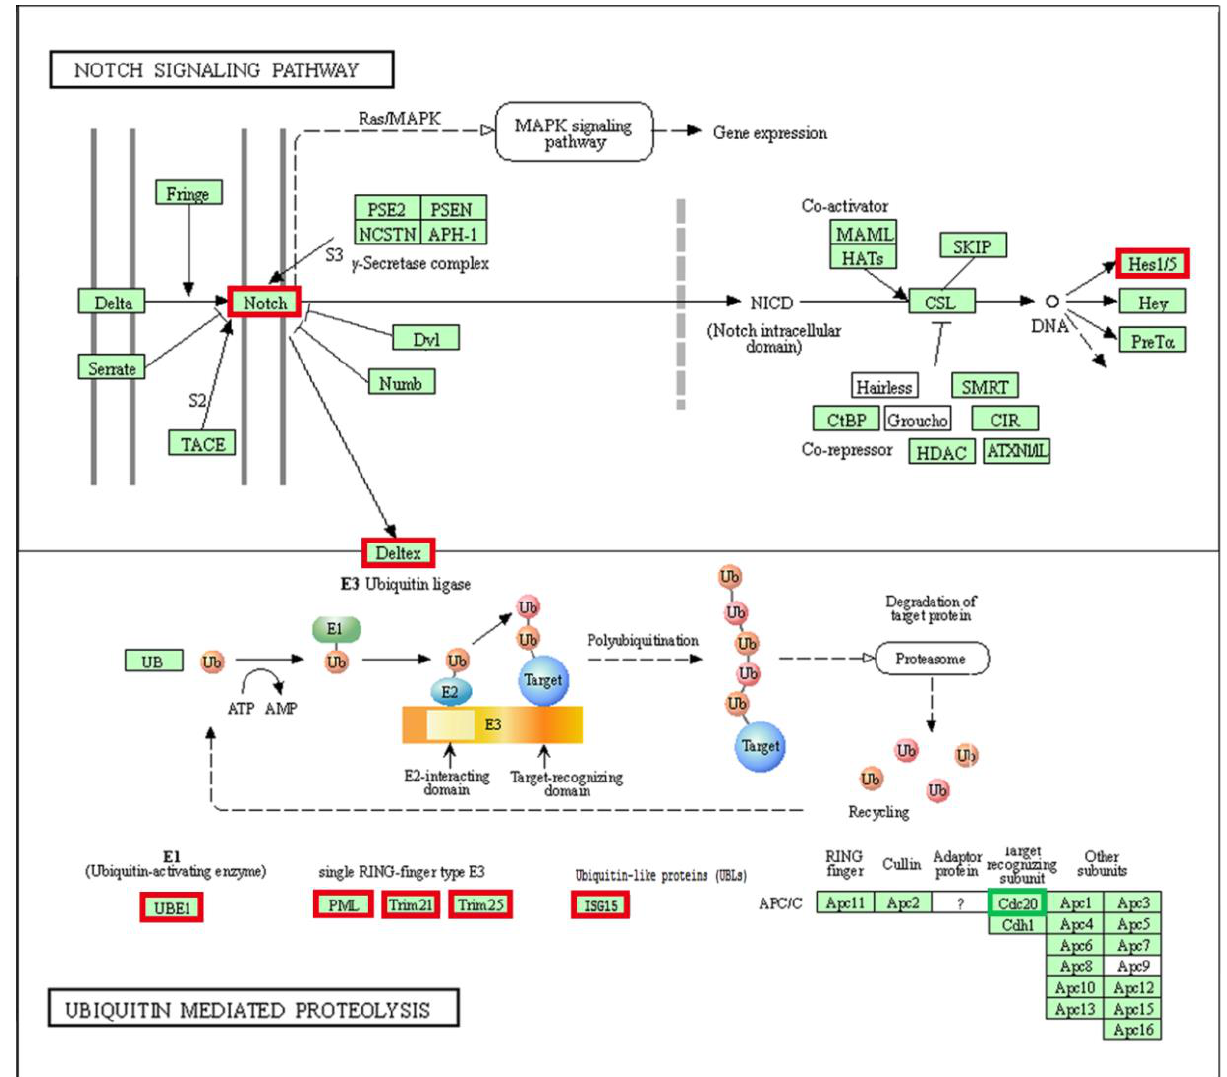
Figure 6. The DEGs in Notch signal pathway and ubiquitin-mediated proteolysis pathway. The red box indicates the up-regulated genes in the pathway after lncFAM200B overexpression, and the green indicates down-regulation.